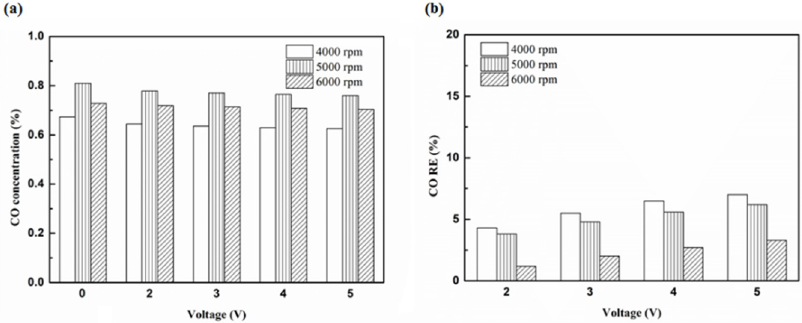
Figure 12. The CO ( a ) emission values and ( b ) RE using platinum in the front of the exhaust pipe.